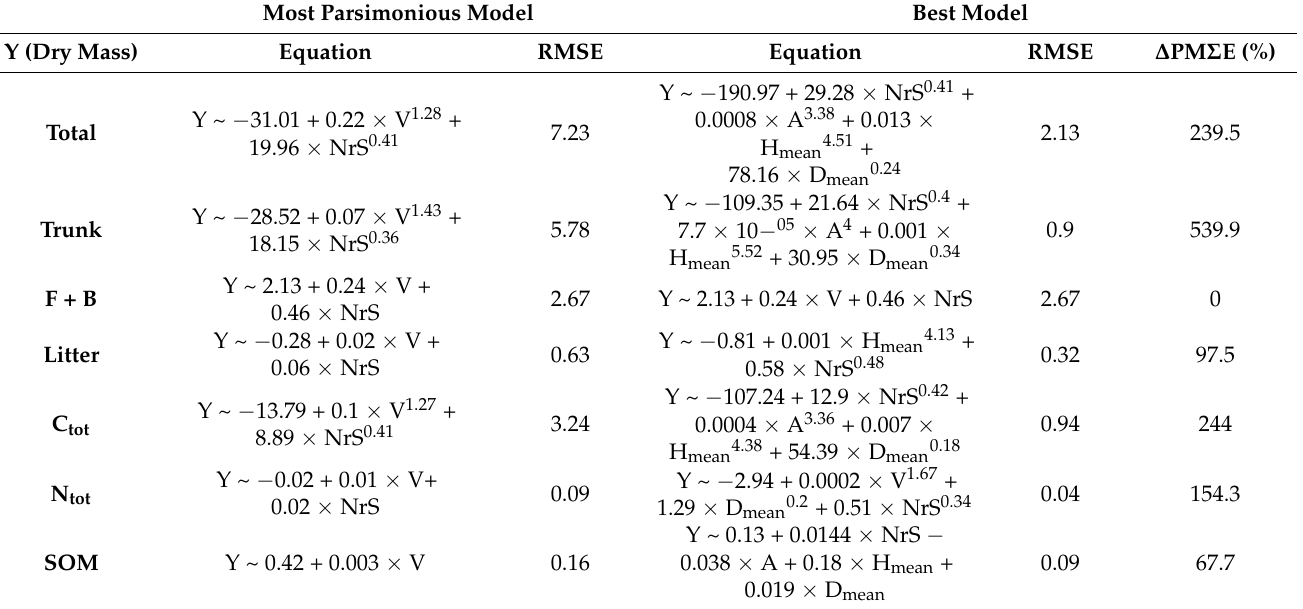
Table 4. Most parsimonious and best fit models for various dependent variables of stands. H mean = mean height (m), A = area (m 2 ), V = volume (m 3 ), and D mean = mean diameter at soil height (cm). RMSE = root mean square error, C tot = total carbon, N tot = total nitrogen, P tot =